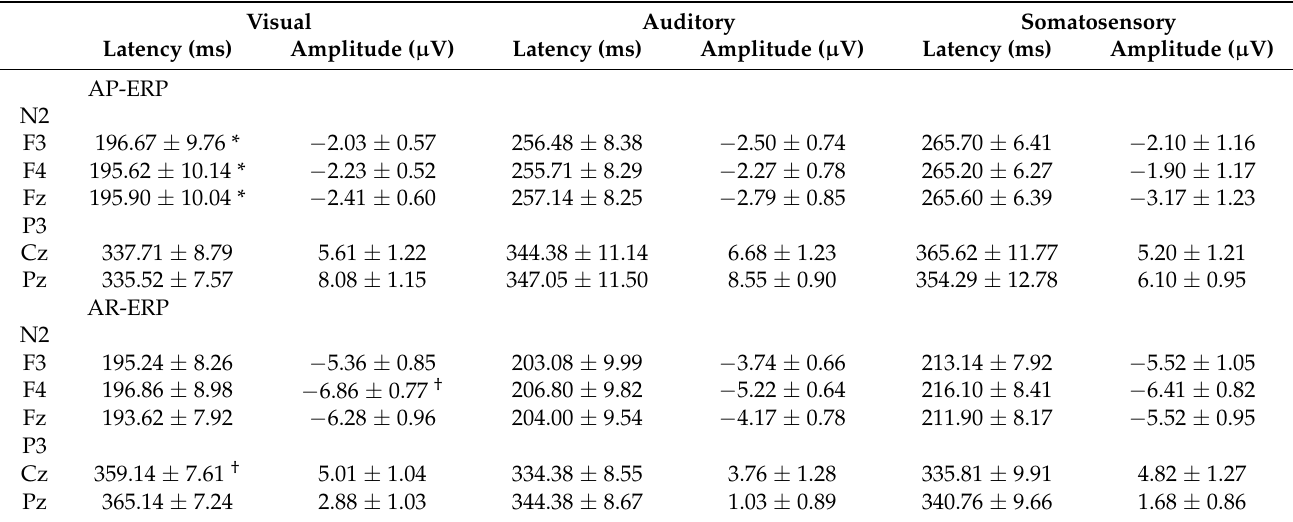
Table 2. Neurophysiological data for each modality.